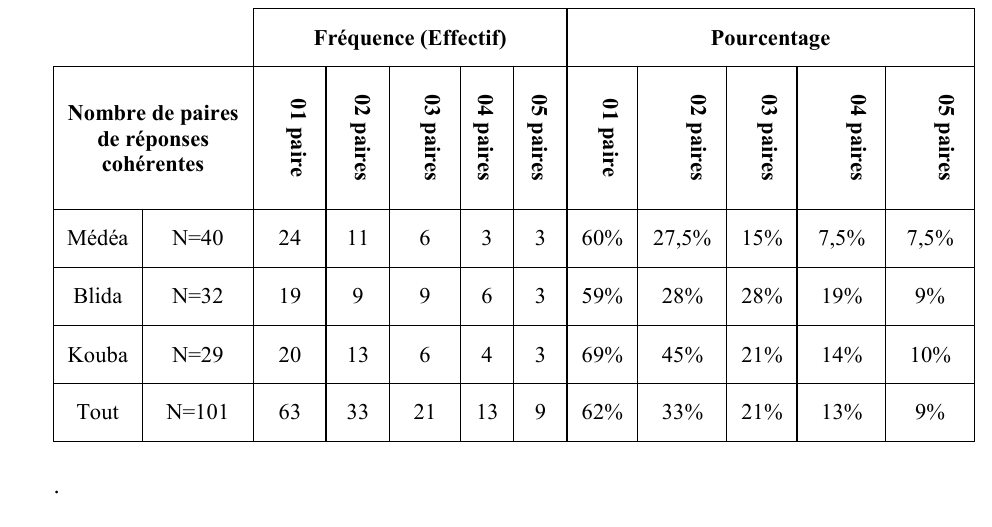
Table 4. Résultats de la cohérence de la perception du modèle.